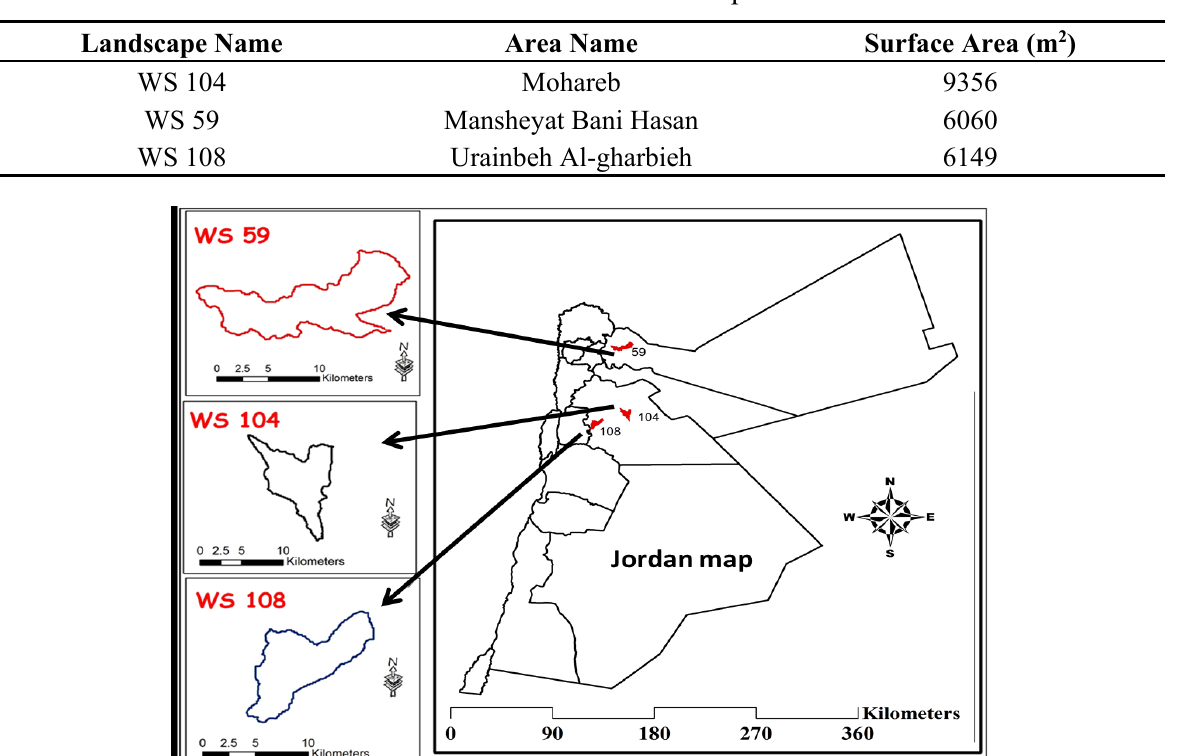
Table 1. The studied landscapes.